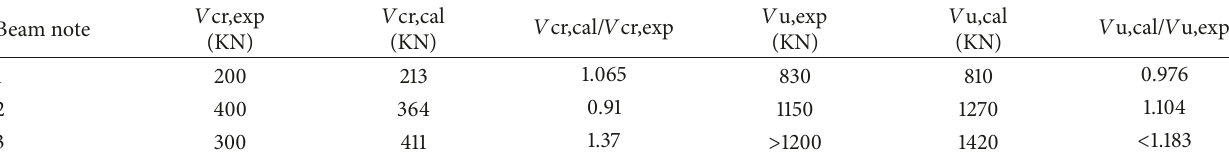
Table 6: Cracking load and ultimate load of three test